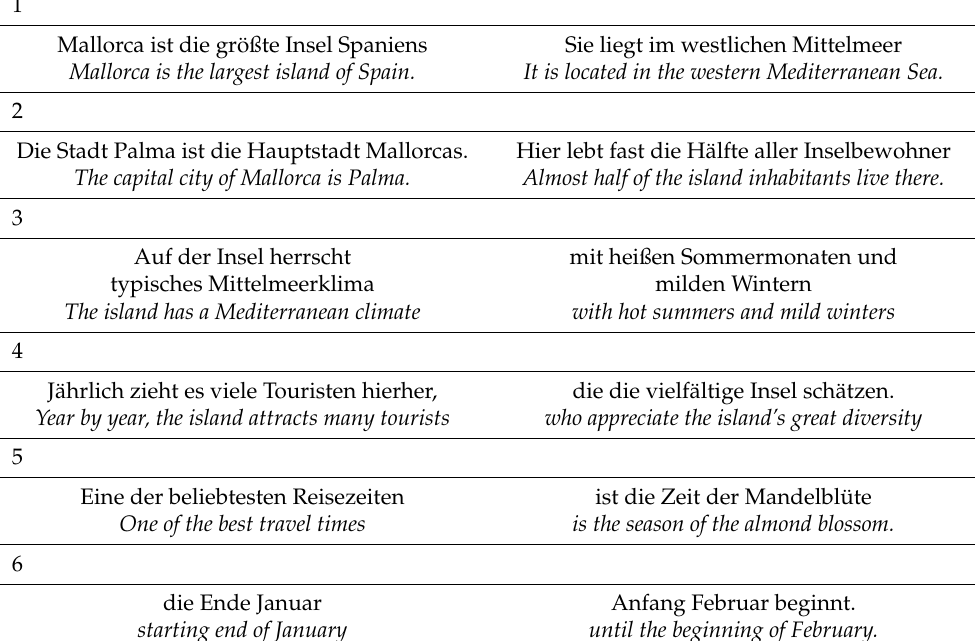
Table A3. Audio-supported reading task (English translations in italics). Test administration was divided into six subsections consisting of two intonation phrases each (separated by blank spaces in the table).